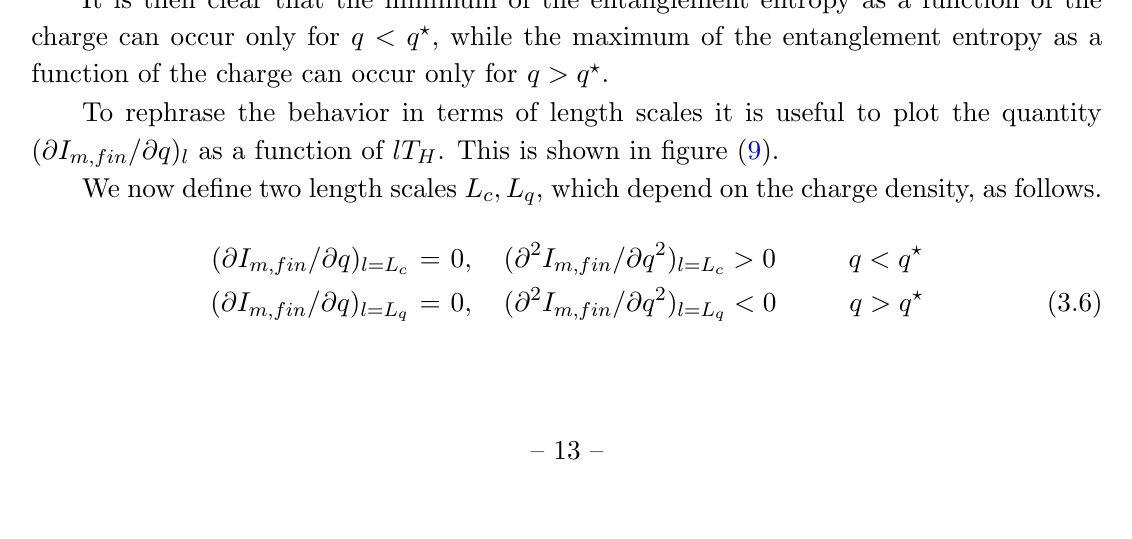
Figure 8 . Normalized entanglement entropy as a function of q=q c for g 2 entanglement entropy for 6 di(cid:11)erent invariant sub-system sizes lT H (from top to bottom, lT H